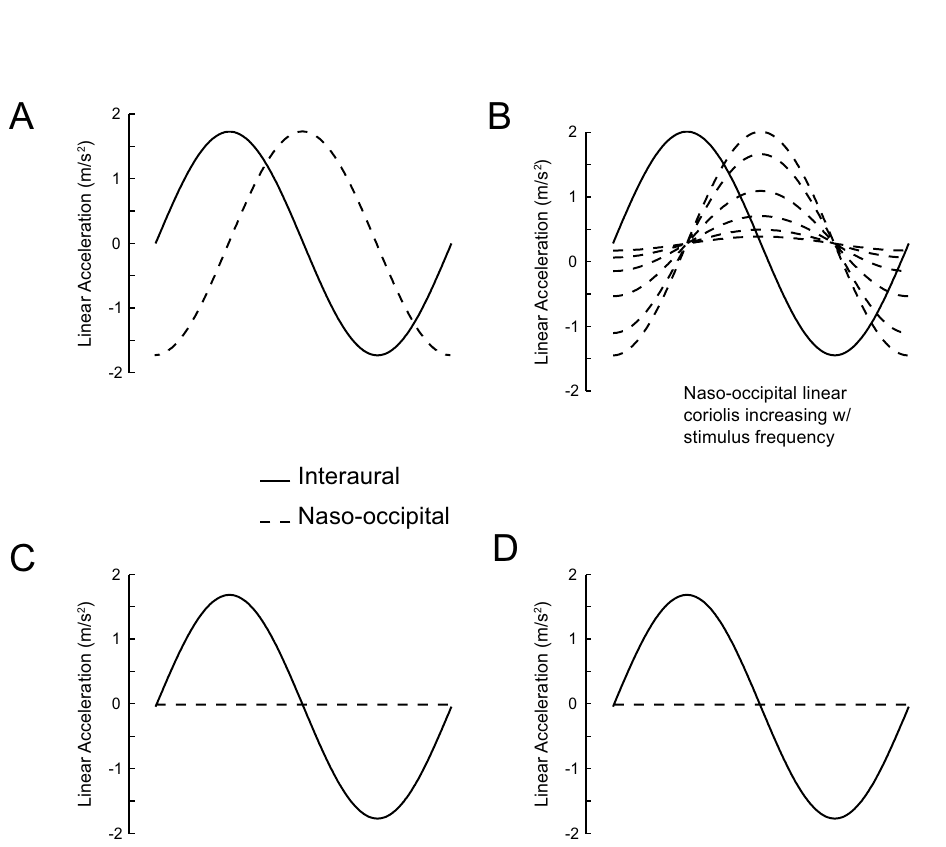
Figure 2. Modulations of linear acceleration along the interaural axis (solid) and the naso-occipital axis (dashed) during the 4 motion paradigms generating a 10° tilt magnitude. ( A ) Off-vertical axis rotation (OVAR) was consistent across all frequencies (velocities). ( B ) Variable radius centrifuge (VRC) generated a Coriolis linear acceleration that increased with stimulus frequency. ( C ) Linear lateral acceleration (LLT) generated pure linear acceleration along the interaural axis with no naso-occipital linear acceleration. ( D ) Earth horizontal axis rotation (EHAR) generated a linear acceleration along the interaural axis due to roll tilt relative to gravity with no naso-occipital linear